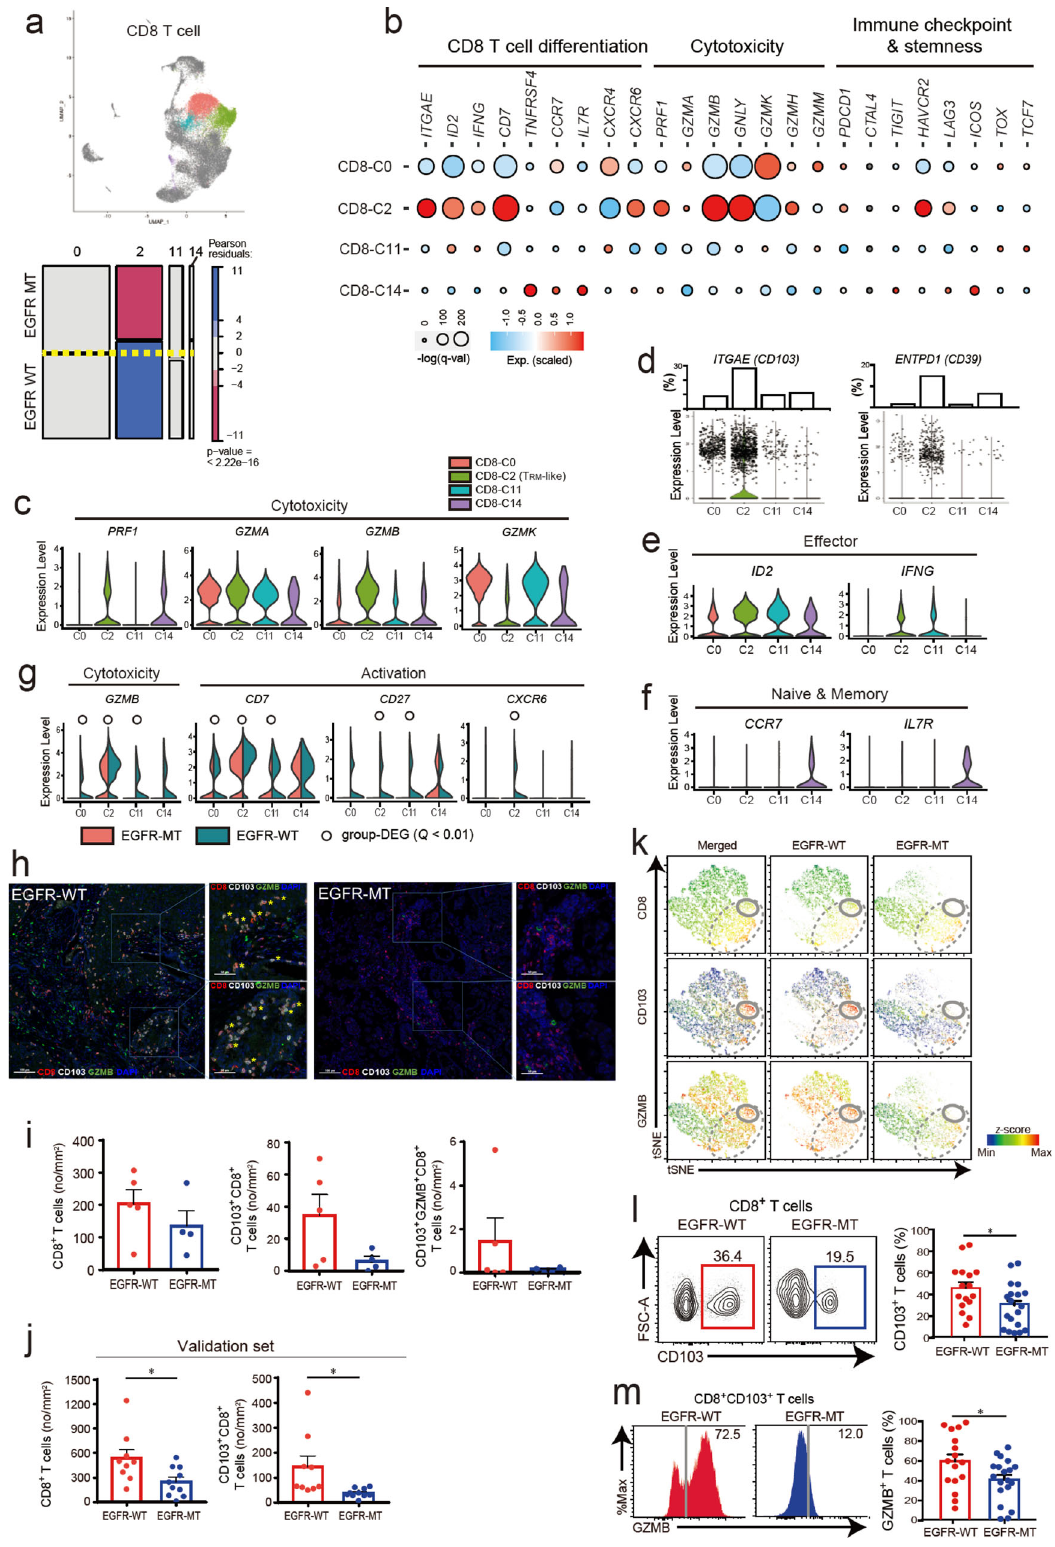
characterized marker genes. Single-cell biology enables discover- ing an increasing number of cell subsets, and identifying speci fi c markers for the subsets would be a daunting task. Therefore, quantifying cell subsets from a heterogeneous cell population using cell-type-speci fi c expression signature has recently been employed. To infer the expression signature of the 18 subsets of